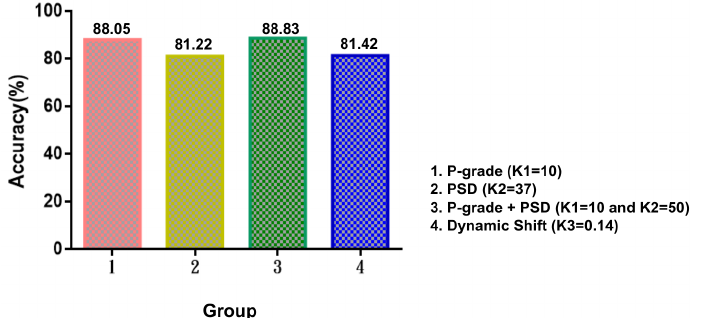
Figure 11. Accuracy of the algorithm in different conditions: P-grade, Piecewise slope detection (PSD), Dynamic shift